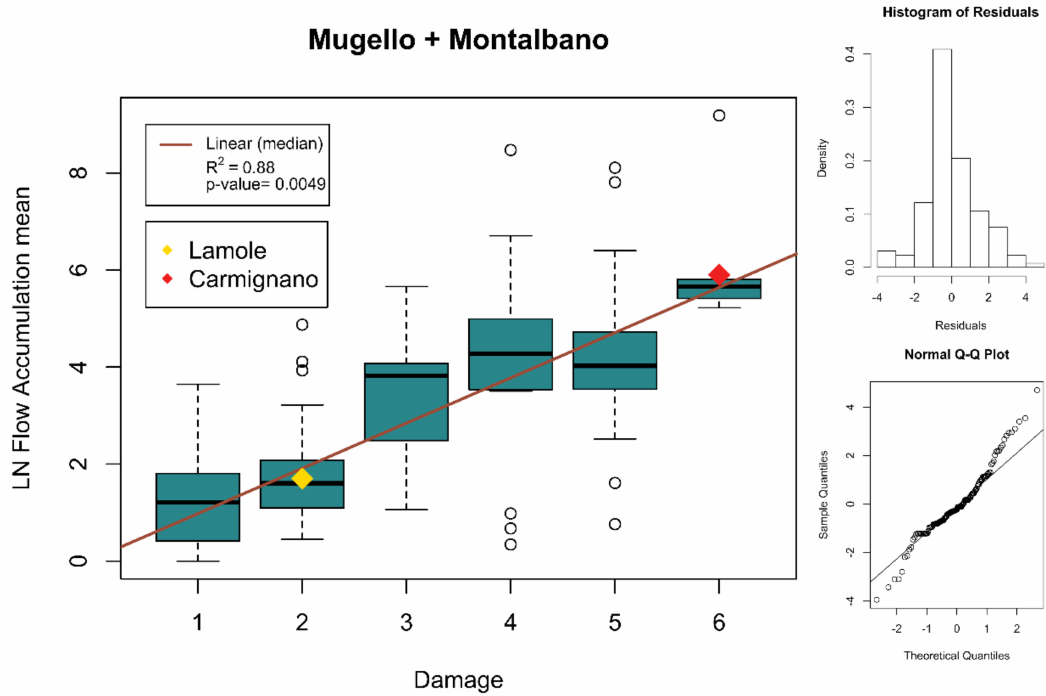
Figure 9. Box plot of the combined dataset and the addition of two values obtained from the Lamole and Carmignano regions (Tuscany, central Italy) [17]. The ordinate now shows the median of the flow accumulation. The graphs on the right show the histogram and Q-Q-plot of the residuals of the regression model—Boxplot: Box = 1.5 × IQR, Q1, Q2, Q3; Whiskers = Min and